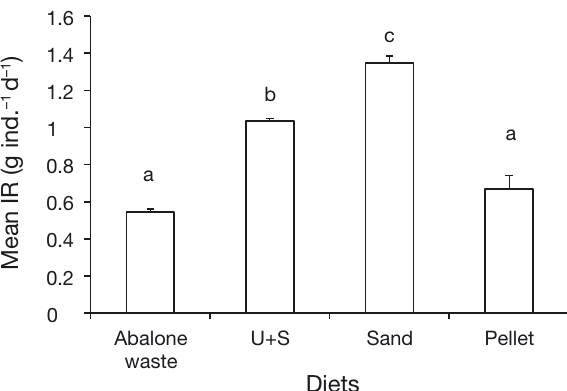
Fig. 1. Mean (+SE) ingestion rate (IR) of Neostichopus gram- matus fed 4 experimental diets n = 32). Different letters above each bar indicate a significant difference between treatments (Dunn, p < 0.05). U+S: Ulva lacinulata mixed with sand